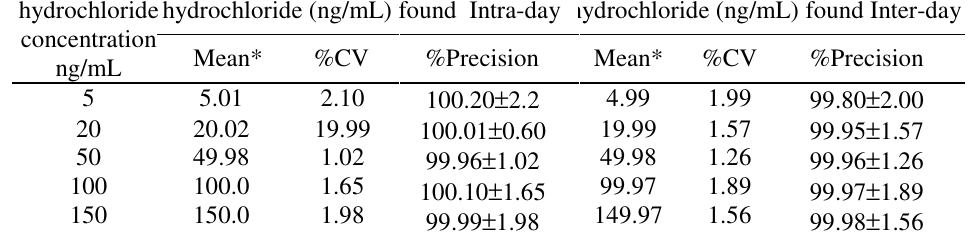
Table 2. Inter- and intra-day precision for nicardipine hydrochloride assay in human plasma of the proposed HPLC